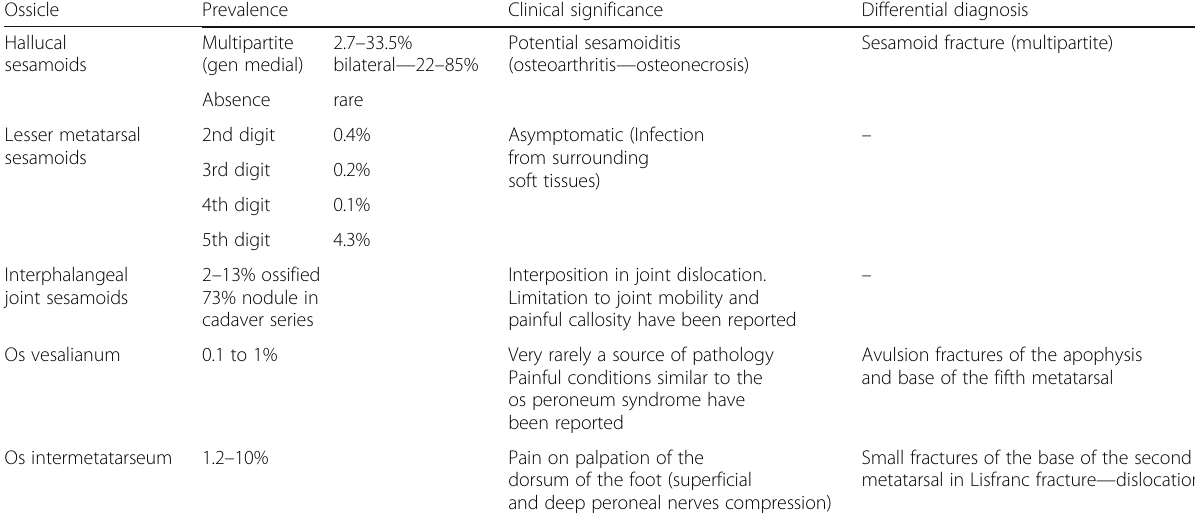
Table 2 Prevalence, clinical significance, and differential diagnosis of the most common types of variants and accessory ossicles in the forefoot Ossicle Prevalence Clinical